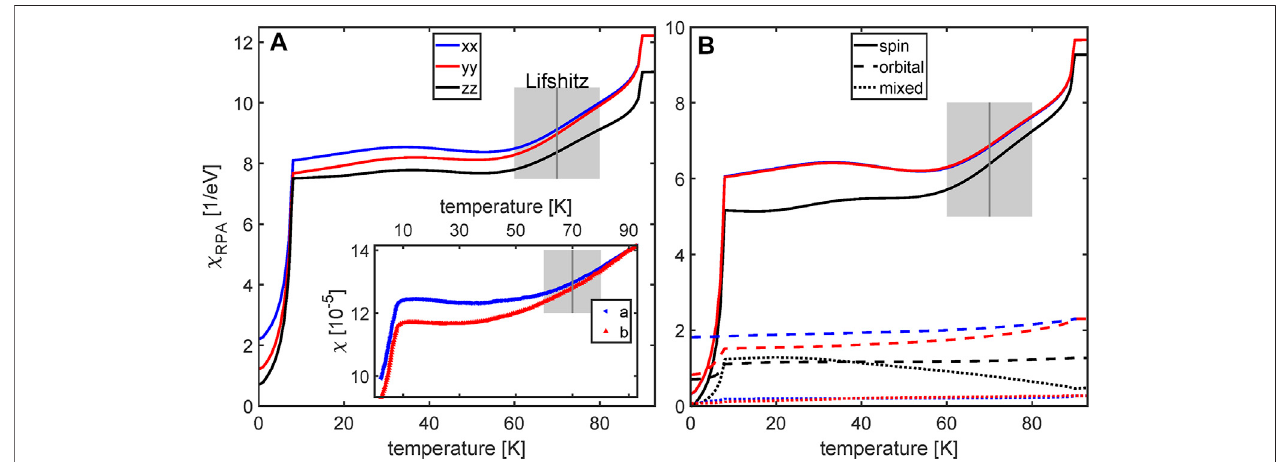
FIGURE2| Calculatedtemperaturedependenceofthemagneticsusceptibility χ ( q → 0)calculatedwithanRPAapproach.In (A) thetotaldiagonalcomponents χ xx , χ yy and χ zz of the susceptibility calculated for scenario B are presented as blue, red and black curves, respectively. The corresponding spin, orbital and mixed contributionstothedifferentcomponentsareshownin (B) assolid,dashedanddottedcurves,respectively.Theinsetin (A) showstheexperimental dataextractedfrom [25] for comparison. The markers do not represent data points from the experiment. The gray boxes illustrate the decrease in susceptibility due to the Lifshitz transitionofthe Y -band.TheboxesarecenteredaroundtheLifshitztransitiontemperature(darkgrayline).Noticethatthebluesolidcurveforthe χ xx spin componentin (B) is almost completely hidden behind the red curve for the χ yy spin component due to tiny in-plane anisotropy in the spin